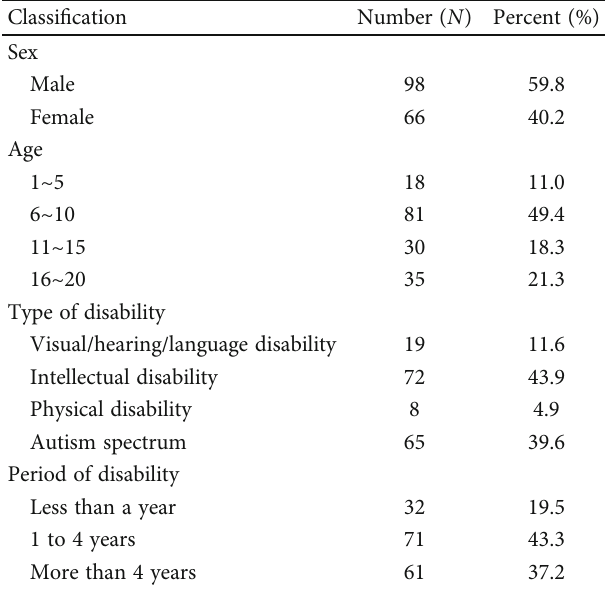
Table 2: General characteristics of children with disability ( N = 164